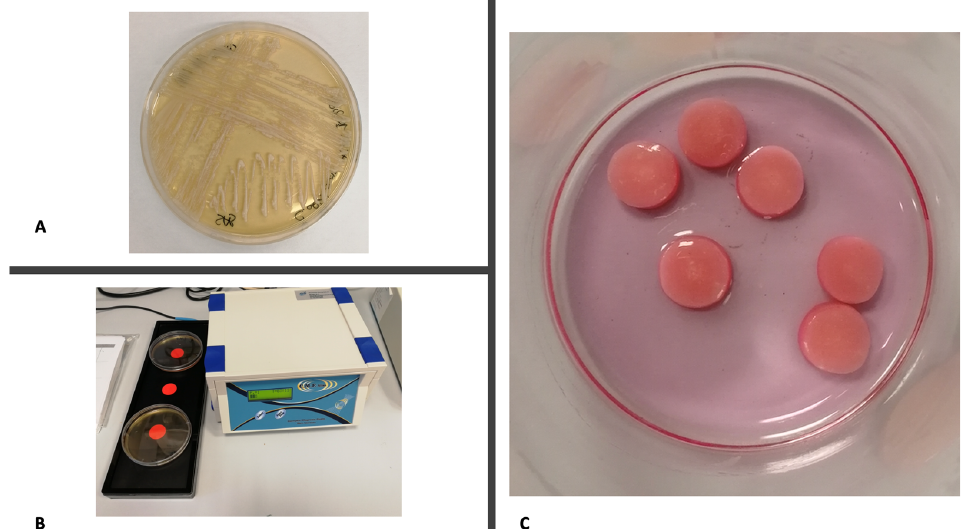
Figure 1. Experimental phases: ( A ) Colonies of Candida albicans on Sabouraud dextrose agar plate. ( B ) Petri dishes containing the fungal suspension during the complex electromagnetic field (CMFs) treatment. ( C ) Ethanol dehydration steps of polyacrylic resin discs, before the SEM observation. The suspension of the broth culture was standardized using a spectrophotometer (Eppendorf, Milan, Italy) adjusting the optical density to OD600 = 0.762 corresponding to 10^7 colony forming units/mL.